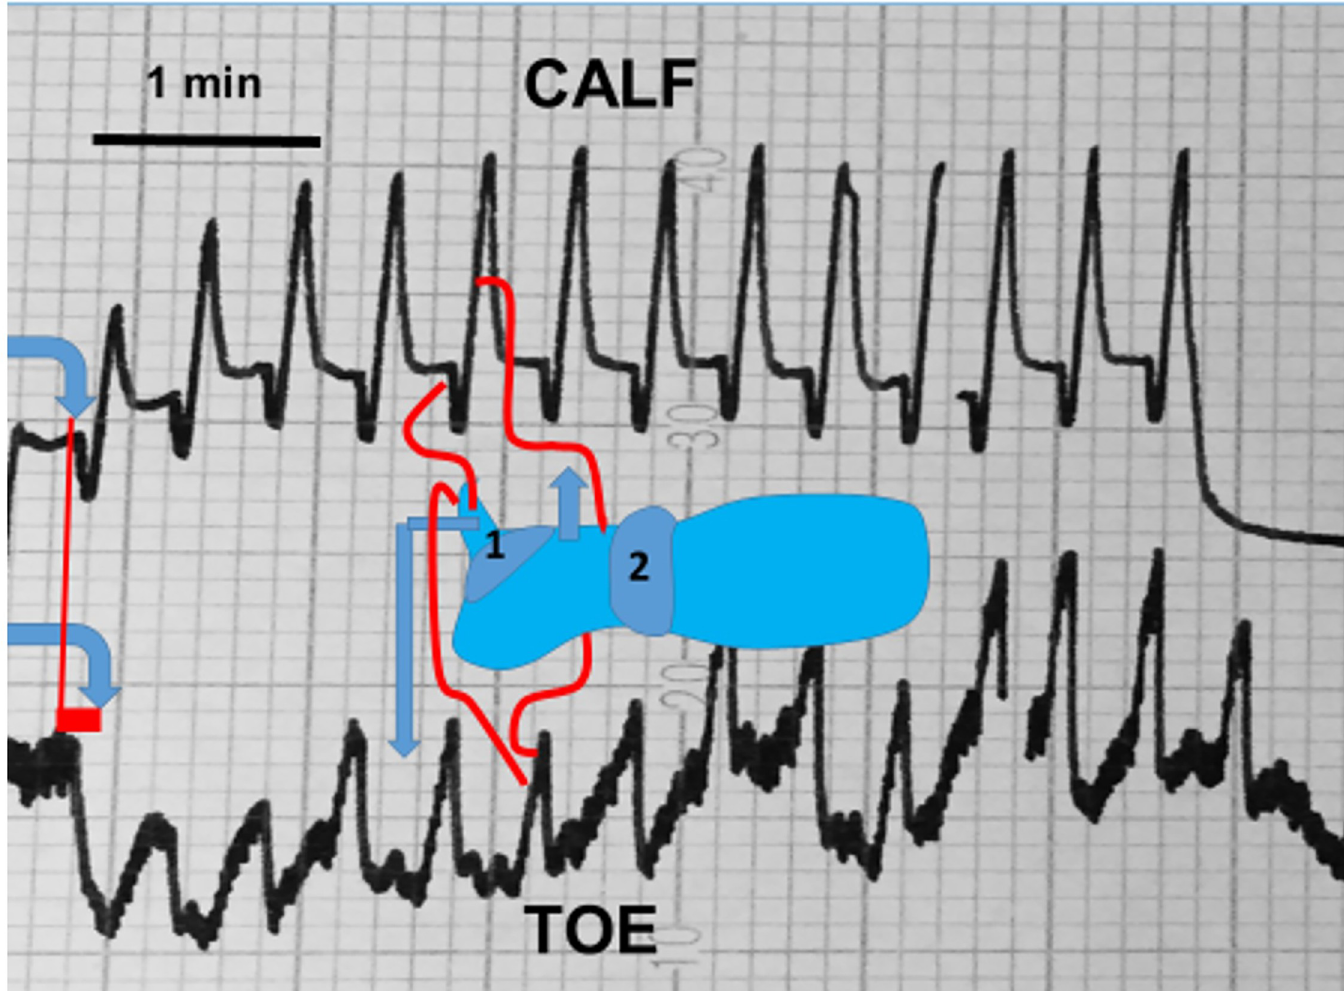
Fig 6. The circumference of the mid-toe and mid-calf was recorded during the arterial assist pump by strain gauge plethysmography in a patient with multifocal calf arteries changes. Number 1 and 2 denote sequentially inflated chambers in front-foot and calf. Blue lines depict strain gauges position. Red lines show time point when inflations began and toe and calf circumferences changed. Elongation of the gauge was read off on the recorder graph scale in mm. Increase in circumference was brought about by the in-flowing blood. Inflation of chamber 1 brought about a 2 sec decrease in calf and increase in toe circumference. Inflation of chamber 2 caused increase of both calf and toe circumference. Deflation was followed by return to the pre-support values. Note that each chamber inflation was followed by increase in toe or calf circumference. This might have been the effect of filling up with blood in occluded toe and calf veins.